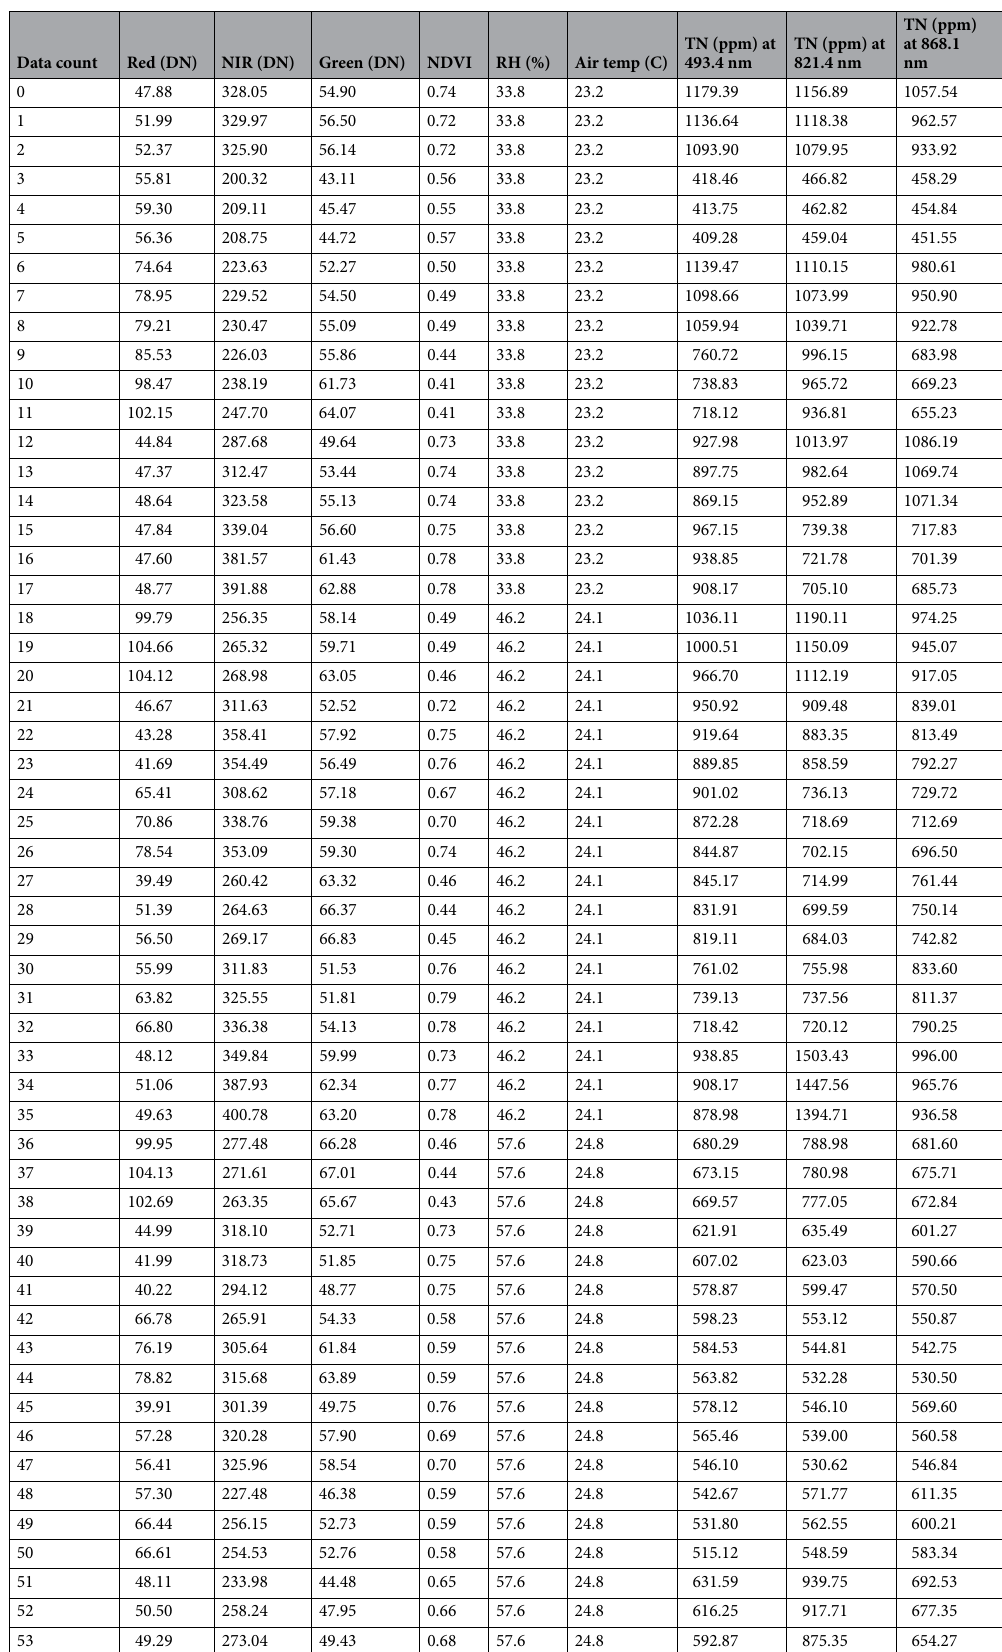
Table 1. Generated training data for the ML